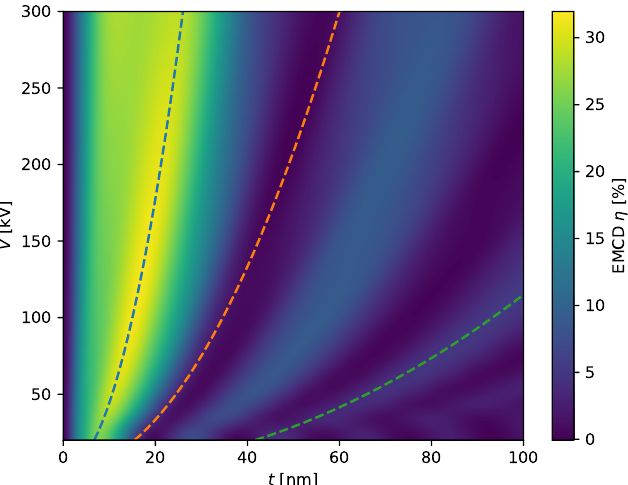
Figure 2. EMCD effect η for various acceleration voltages V and thicknesses t for bcc Fe as simulated with “bw”. The dashed lines show (arbitrary) curves with t ∝